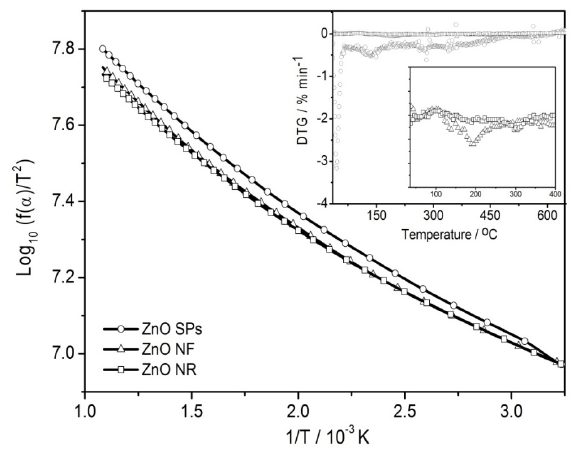
[ f (α)/ T 2 ] vs. 1/T for determining of the activation Figure 4: Plot of log 10 energy and other thermodynamic activation parameters with f (α) = – log (1–α). The inset shows the derivative thermogravimetric curves 10 of ZnO NFs, ZnO SPs, and ZnO